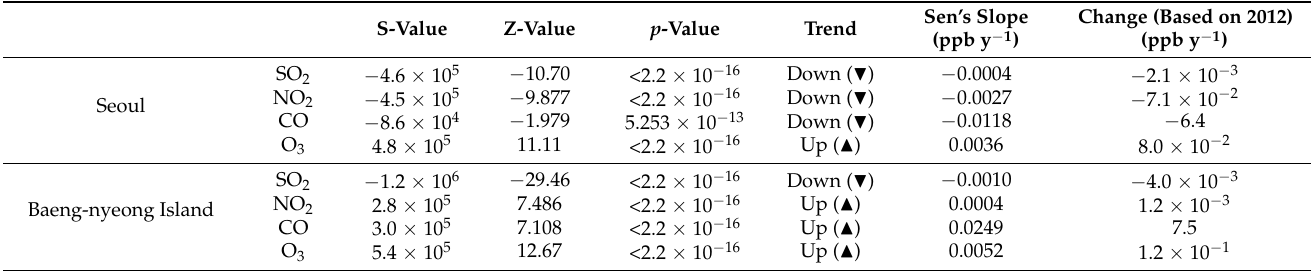
Table 3. The results of the Mann–Kendall test and Sen’s slope estimation for ambient gaseous pollutants between 2012 and 2019. S-Value Z-Value p -Value Trend